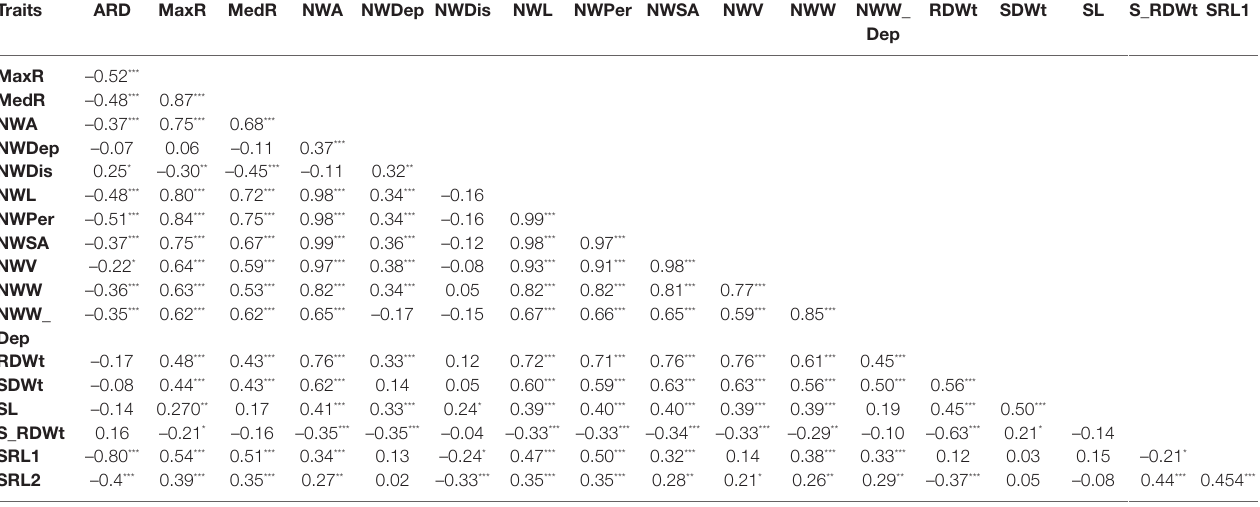
TABlE 2 | Pairwise correlation of the traits.